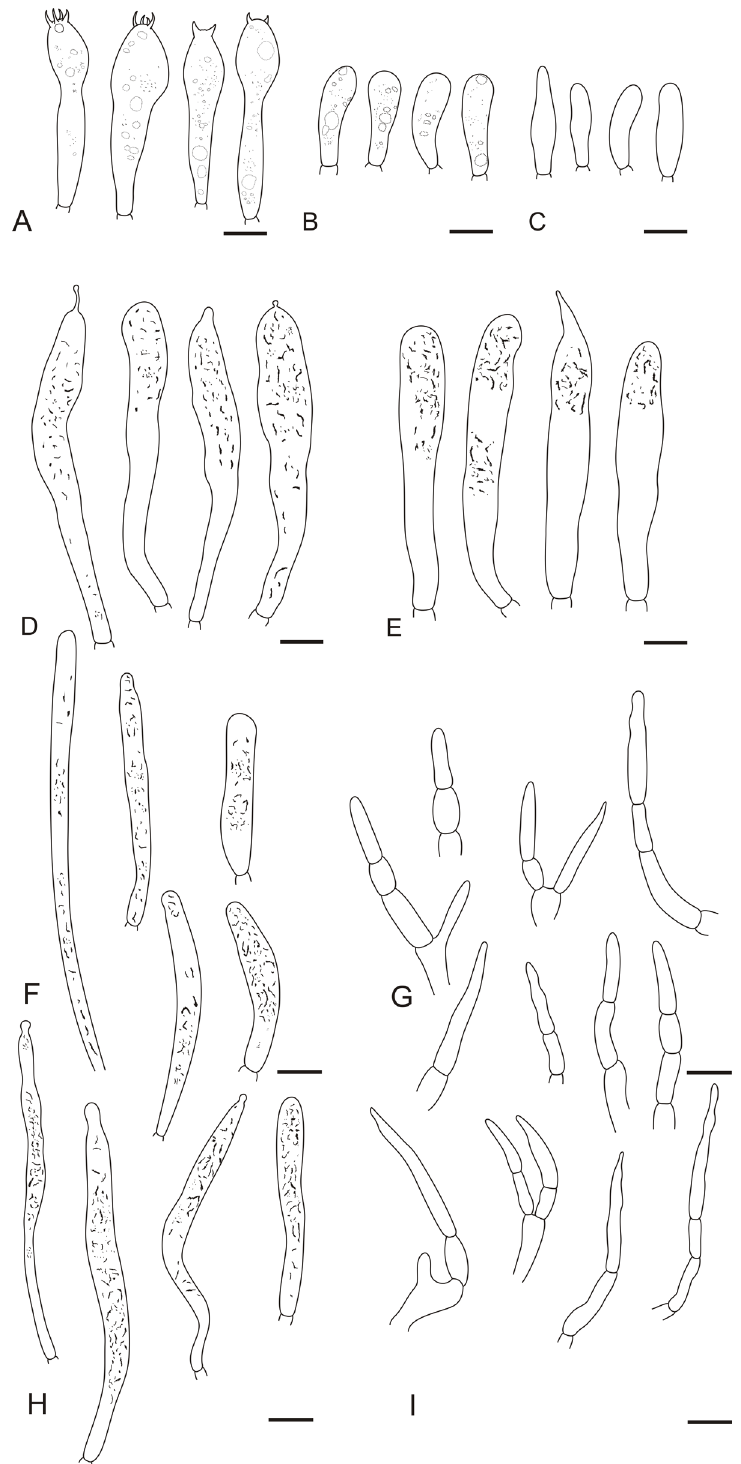
Fig. 6. Microscopic structures of lamellae of Russula wulingshanensis C.L.Hou, G.Q.Cheng & H.Zhou sp. nov., holotype (BJTC C403). A . Basidia. B . Basidiola. C . Marginal cells. D . Pleurocystidia. E . Cheilocystidia. F . Pileocystidia near the pileus margin. G . Pileocystidia near the pileus centre. H . Hyphal terminations near the pileus margin. I . Hyphal terminations near the pileus centre. Scale bars = 10